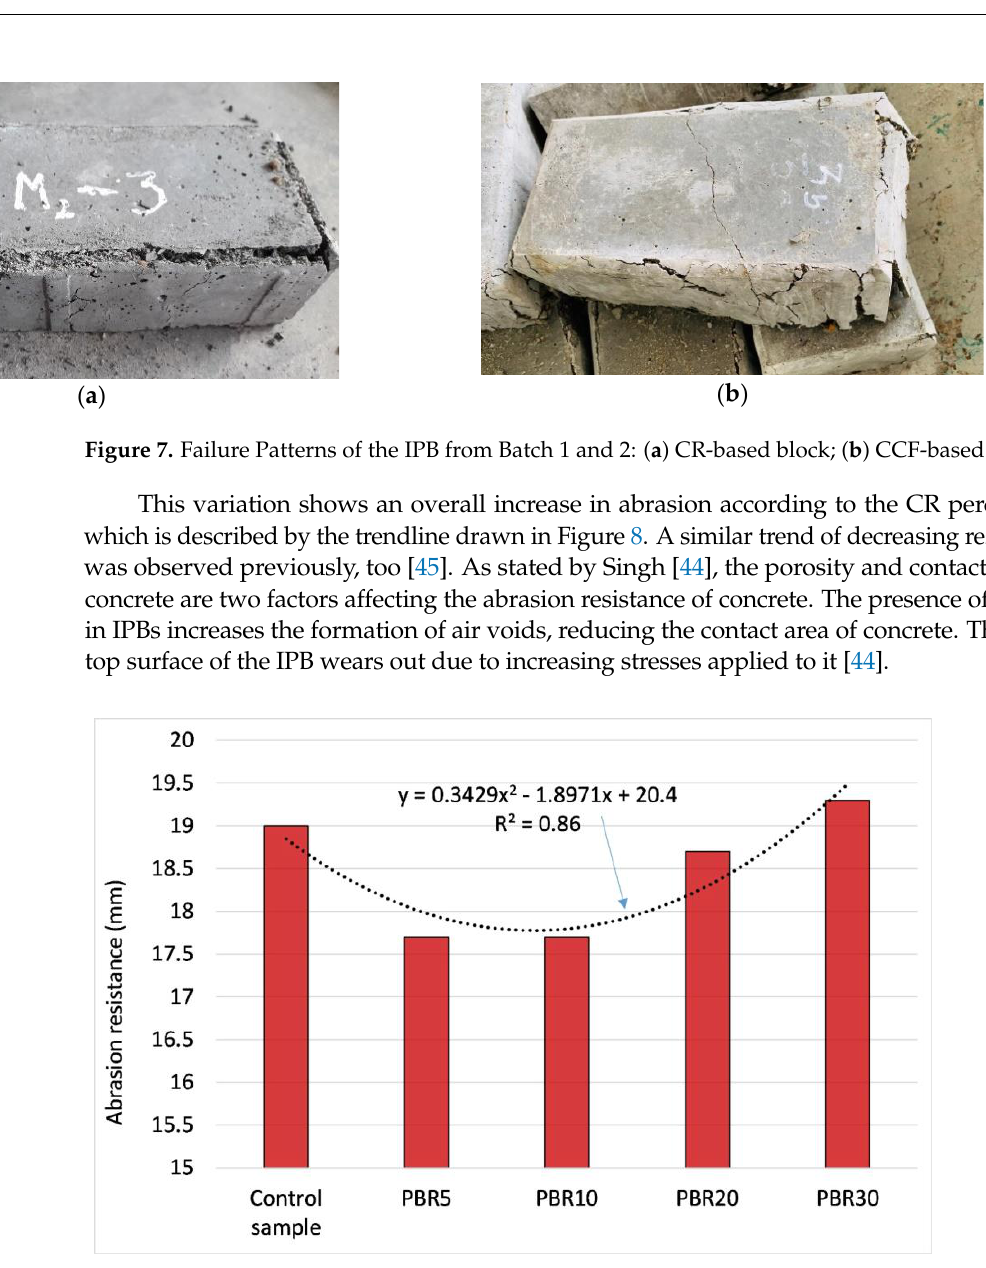
Figure 8. Abrasion resistance of CR IPB at 28 days.